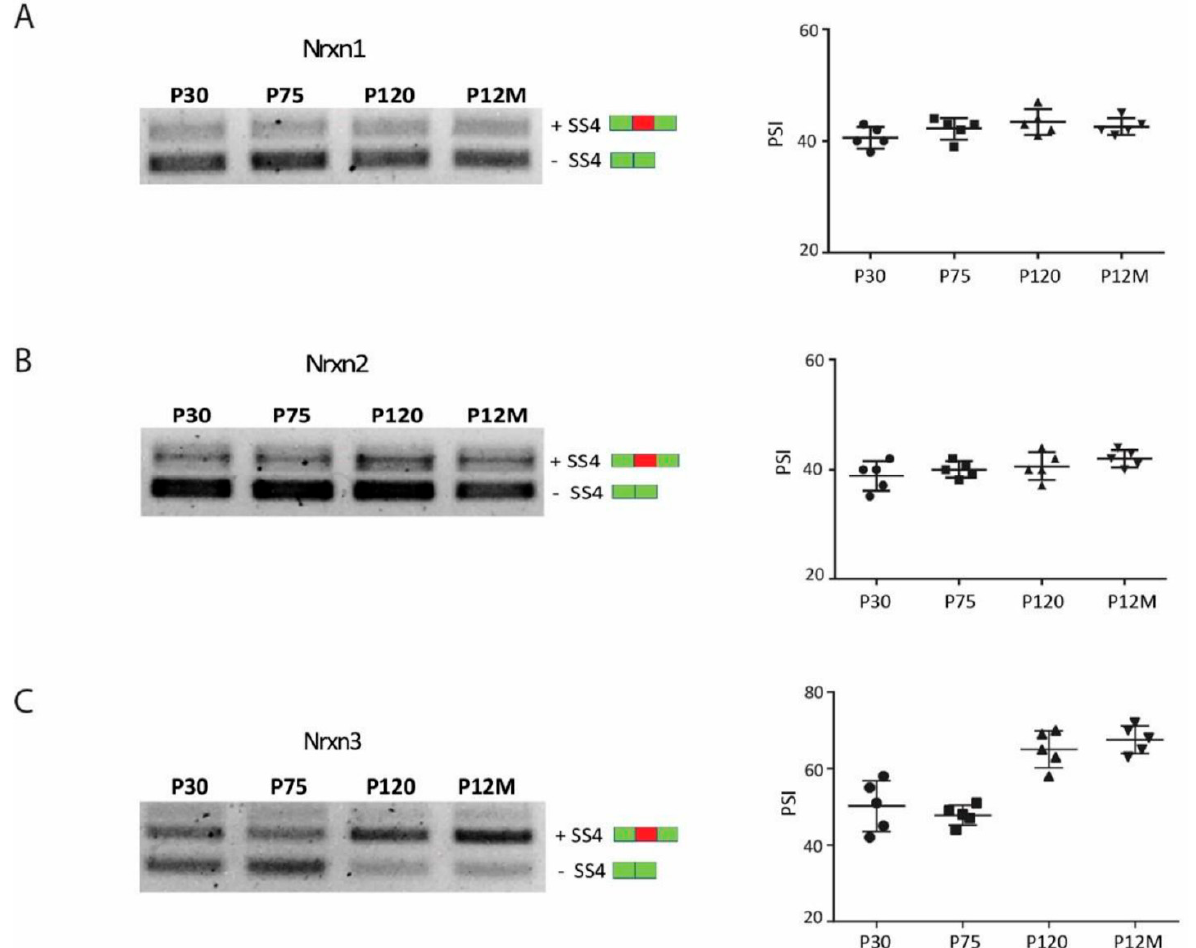
Figure 3. Neurexins splicing pattern in postnatal frontal cortex. RT-PCR analysis of Nrxns splice variants at SS4 in FC of mice at different ages: P30, P75, P120, and P12M ( n = 5 mice for each group). Representative splicing pattern of Nrxn1 ( A ) Nrxn2 ( B ), and Nrxn3 ( C ). On the right, the corresponding scatter plots shows the densitometric analysis (ImageJ-win64) expressed as PSI (percent spliced in). The splicing pattern for Nrxn1–2 does not change during age, while Nrxn3 shows an increase in the +SS4 isoform from adult age. Statistical analysis was performed by ordinary one-way ANOVA. Error bars represent SD. Green box: constitutive splice site. Red box: alternative splice site.